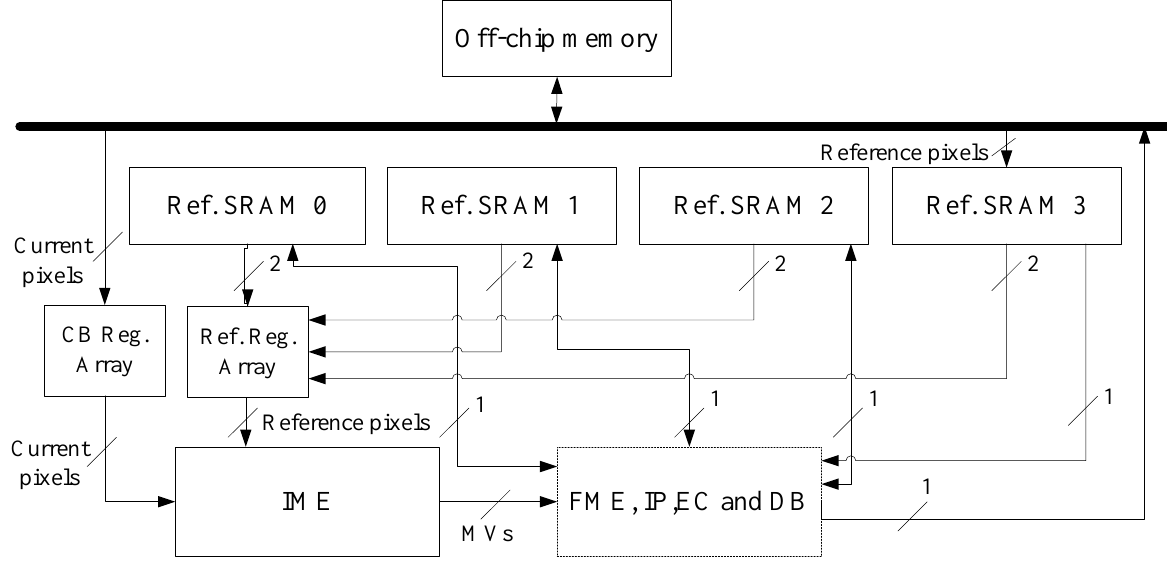
Figure 18. The implemented architecture for Inter-D